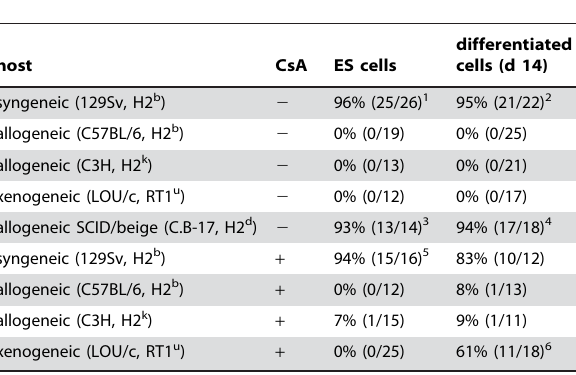
Table 2. Tumor formation after subcutaneous inoculation of ES or in vitro differentiated cells into various